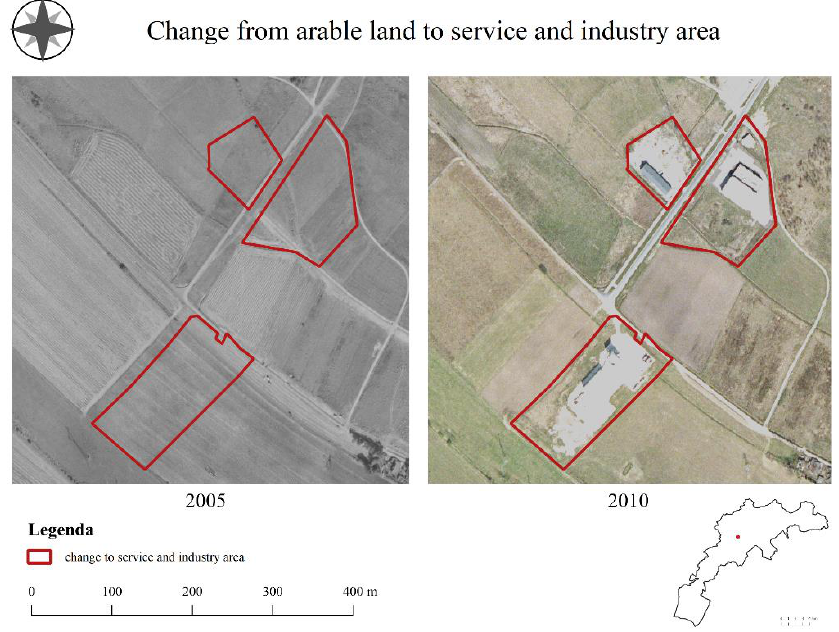
Figure 7. Development of transportation areas in the city of Jelenia Góra.